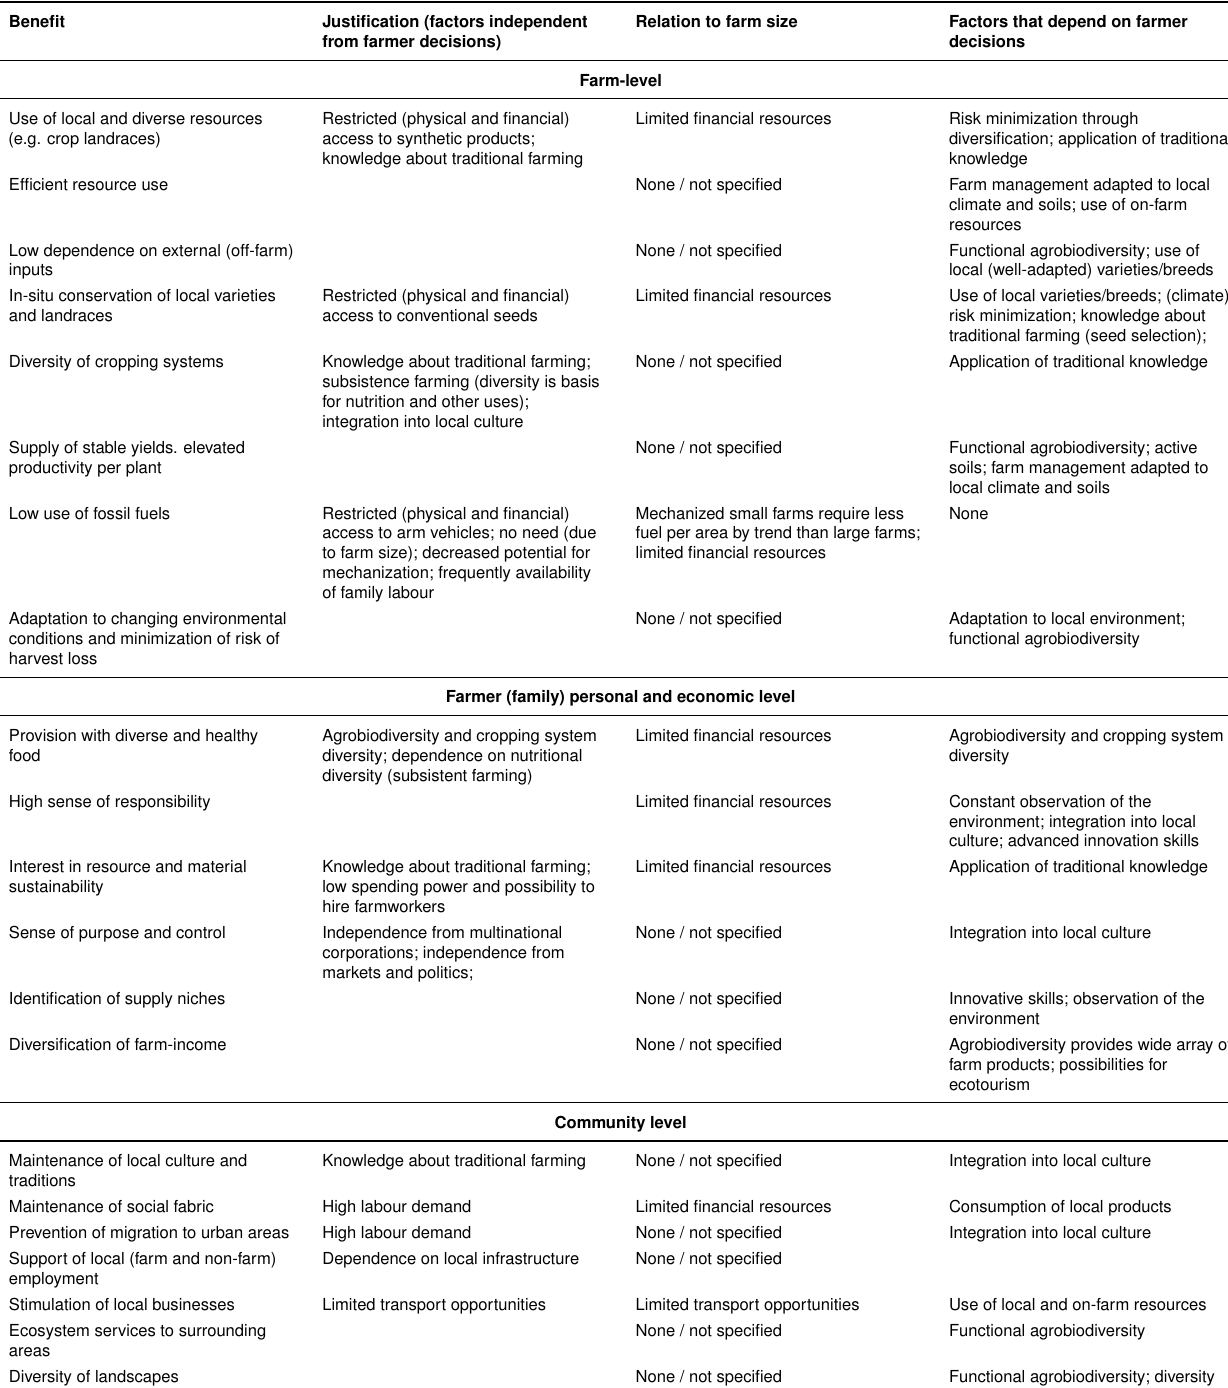
Table 3. Explanations of sustainability benefits of small farms [1,2,4,18,19,23–25,31,34,41,43,45,47,80], their direct relation to farm size and to the farmer’s management decisions and